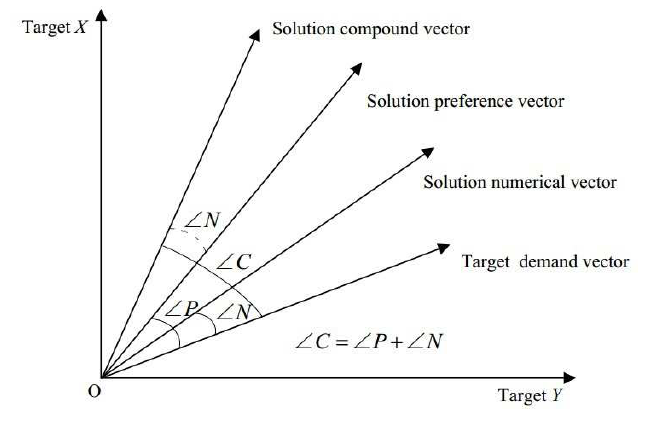
Figure 3. The schematic diagram of the compound angle